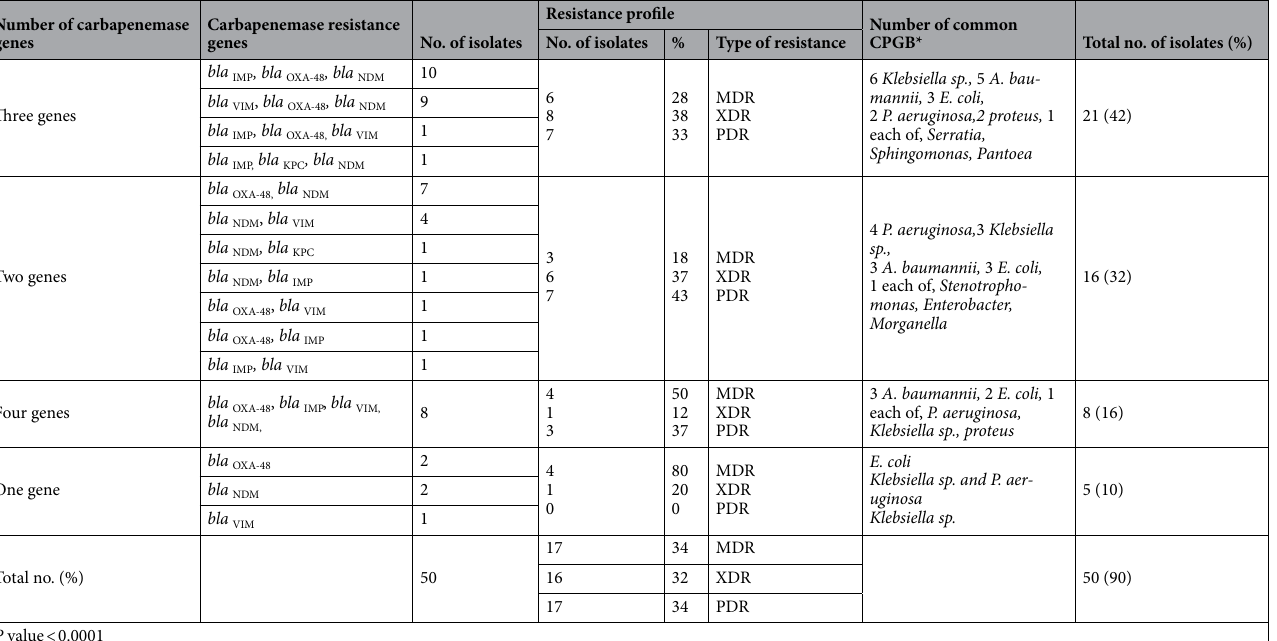
Table 2. Genotypic and phenotypic resistance patterns among CPGB. CPGB: Carbapenemase-producing Gram-negative